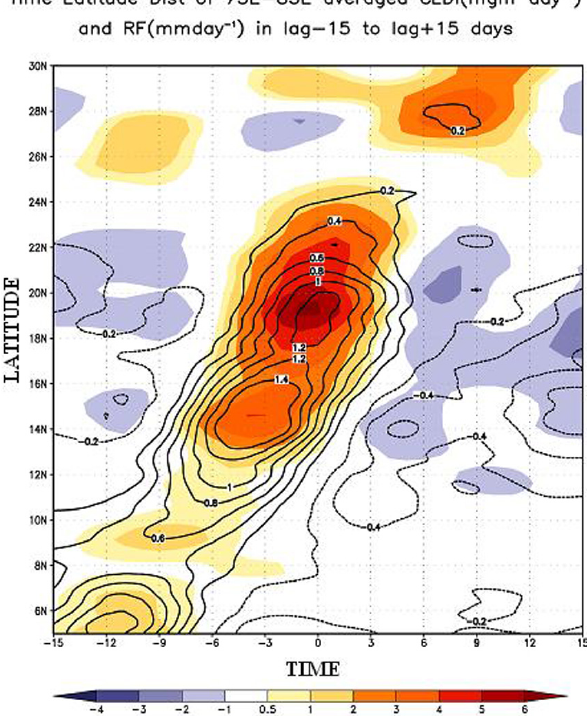
Fig. 9. Meridional-vertical structure of (a) moisture convergence (s − 1 ), (b) moist static Energy (KJkg − 1 ), (c) vertical velocity (Pas − 1 ) and (d) vorticity (s − 1 ) with respect to convection centre based on MERRA data.